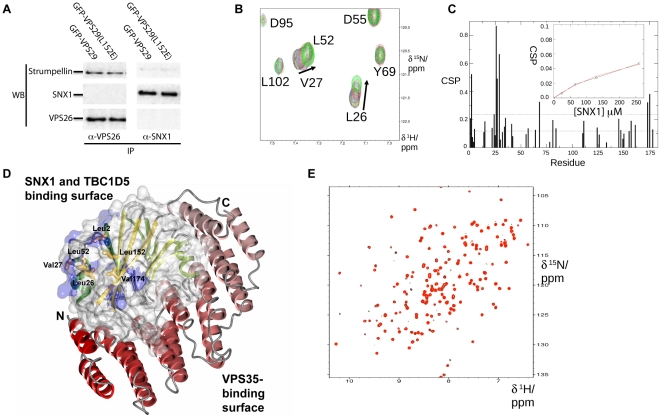
VPS29 binds specifically to SNX1 but with low affinity in vitro.(A) Immunoprecipitations from HeLa cells do not detect association of retromer with SNX1 even in the presence of increased levels of VPS29 expression. Cells expressing GFP-VPS29 or GFP-VPS29(L152E) mutant were subjected to immunoprecipitation with either VPS26 or SNX1 antibodies. VPS26 (and thus VPS29-containing retromer) associates readily with the effector complex containing strumpellin [32], confirming that known binding partners can be detected in the immuno-isolates. However, no SNX1 is detected, and furthermore, in reverse experiments SNX1 does not precipitate retromer indicating that their association in vivo is relatively weak or transient. (B) Titration of VPS29 with SNX1 in NMR experiments reveals specific but weak association in vitro. A selected region is shown for the 15N-HSQC spectra of VPS29 in the presence of increasing concentrations of SNX1. (C) Chemical shift perturbations are shown for VPS29 in the presence of SNX1. Inset shows a plot of the chemical shift perturbation for Leu26 NH as a function of SNX1 concentration. (D) SNX1 binds to VPS29 via the conserved hydrophobic surface on the opposite face to the metal-binding pocket and VPS35 binding interface. Residues that show the largest perturbations on SNX1 binding (>2 standard deviations) are mapped on the VPS29 structure in blue. The structure of VPS29 (surface, and green ribbons) is shown in complex with VPS35(476–780) (red ribbons) [24]. The side-chains of the VPS29 hydrophobic surface are indicated. (E) Mutation of the hydrophobic surface of VPS29 (L152E) prevents VPS29-SNX1 association. The [1H,15N]-HSQC spectra for VPS29(L152E) in the absence (black) and presence (red) of SNX1 indicates no significant association is occurring.